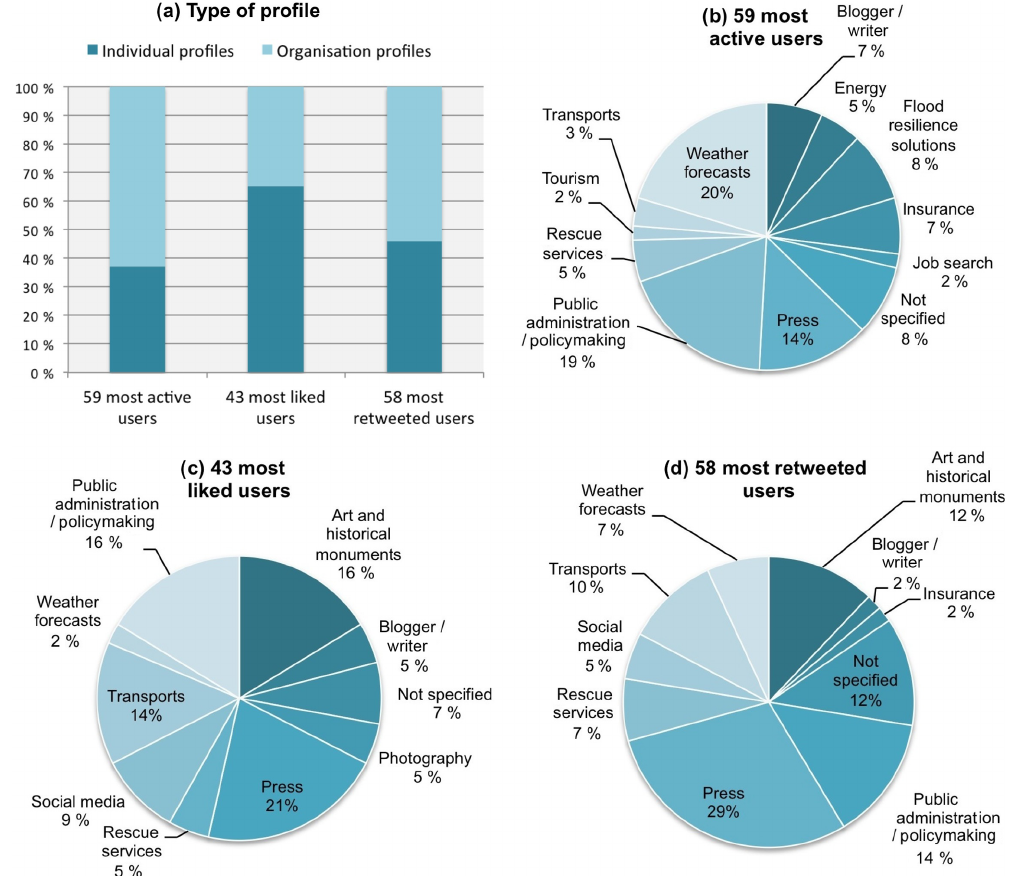
Figure 5. The users’ behaviour (Twitter coverage of the 2016 Seine River flood): (a) percentage of individual profiles; (b) the area of activity of the most active users (59 users that published more than 10 tweets in 1 month); (c) the area of activity of the most liked users (43 users that received more than 50 likes per tweet in 1 month); (d) the area of activity of the most retweeted users (58 users that received more than 50 retweets per tweet in 1 month). These data were extracted from the tweet corpus and completed with information available on Twitter users’ profile